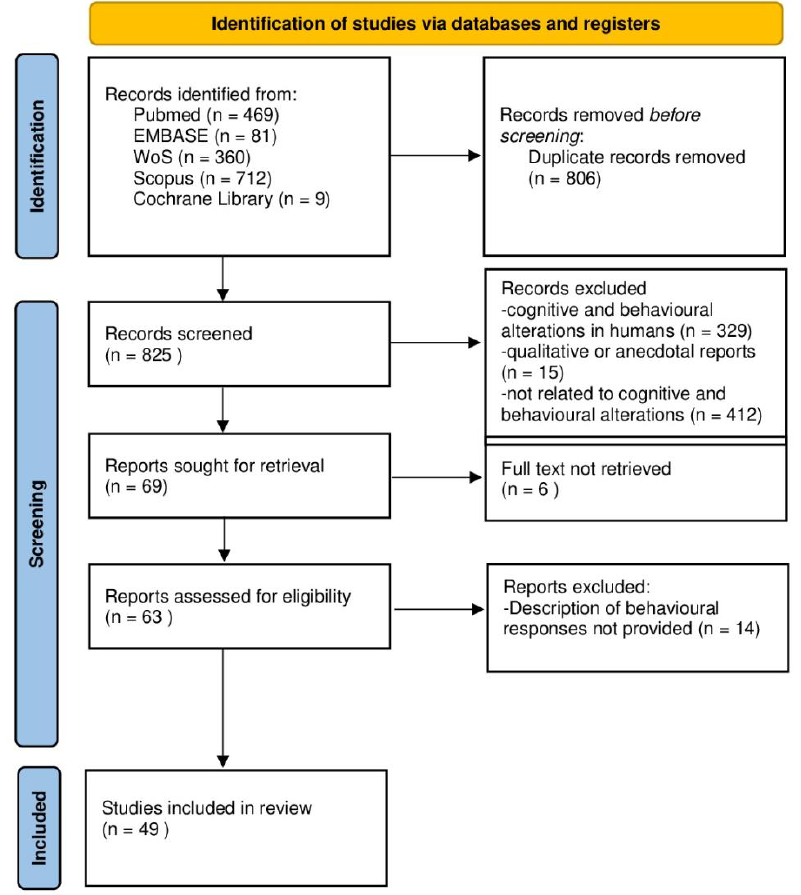
Figure 1. Flow Chart of the bibliographic search.